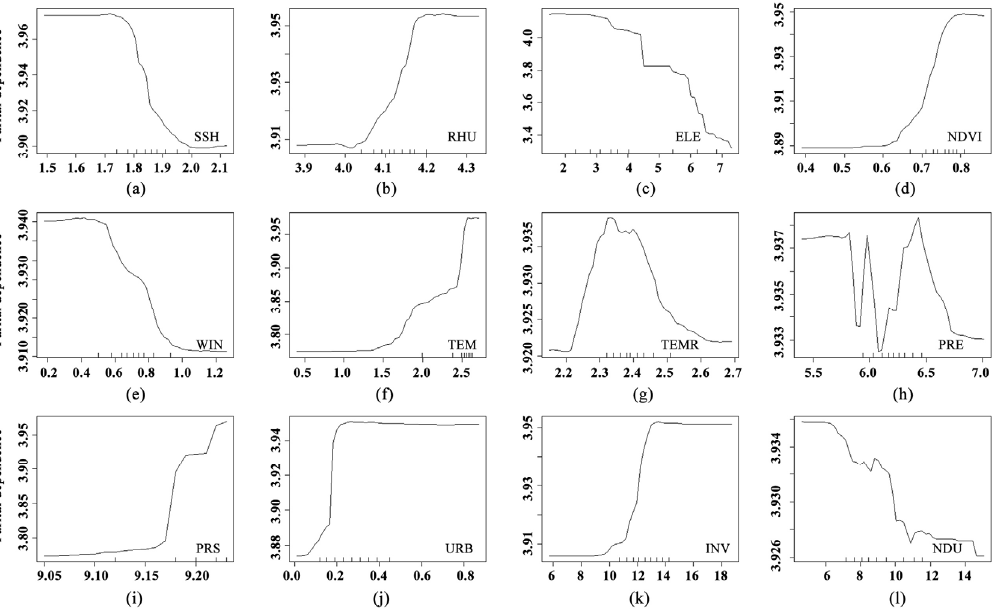
Figure 3. Partial dependency plots of factors affecting PM 2.5 concentrations in the BTH from 2000 to 2016. ( a ) SSH; ( b ) RHU; ( c ) ELE; ( d ) NDVI; ( e ) WIN; ( f ) TEM; ( g ) TEMR; ( h ) PRE; ( i ) PRS; ( j ) URB; ( k ) INV; ( l ) INDU. Each variable name is the same as in Table 1.